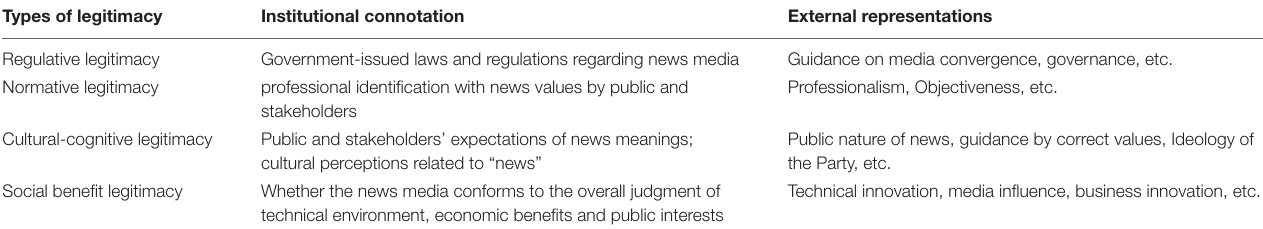
TABLE 1 | Multiple legitimacy of mass media